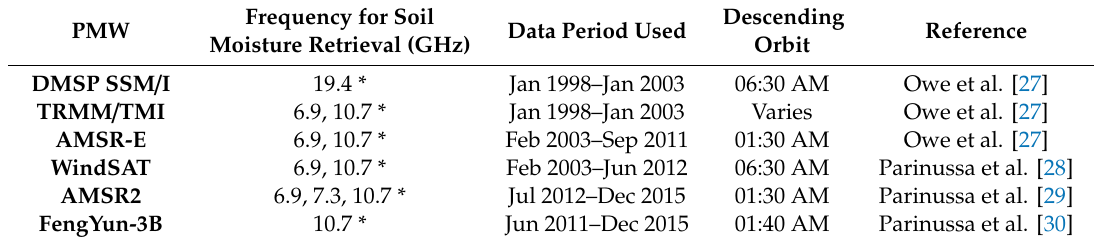
Table 1. Summary of passive microwave sensors used (the frequencies used are those with